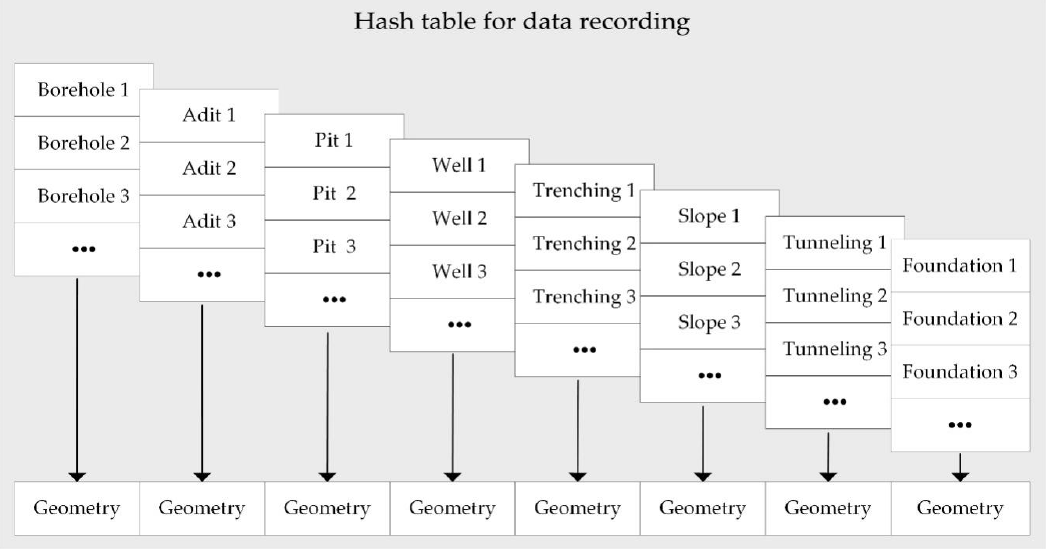
Figure 4. Data recording architecture.